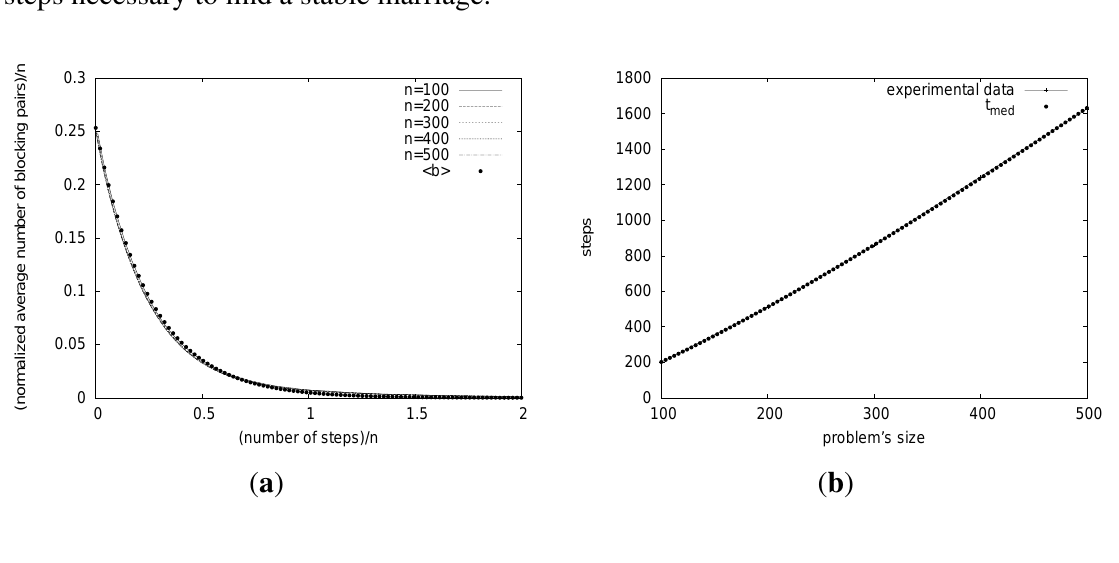
Figure 2. Results using SML2. ( a ) Blocking pair ratio during the execution; ( b ) number of steps necessary to find a stable